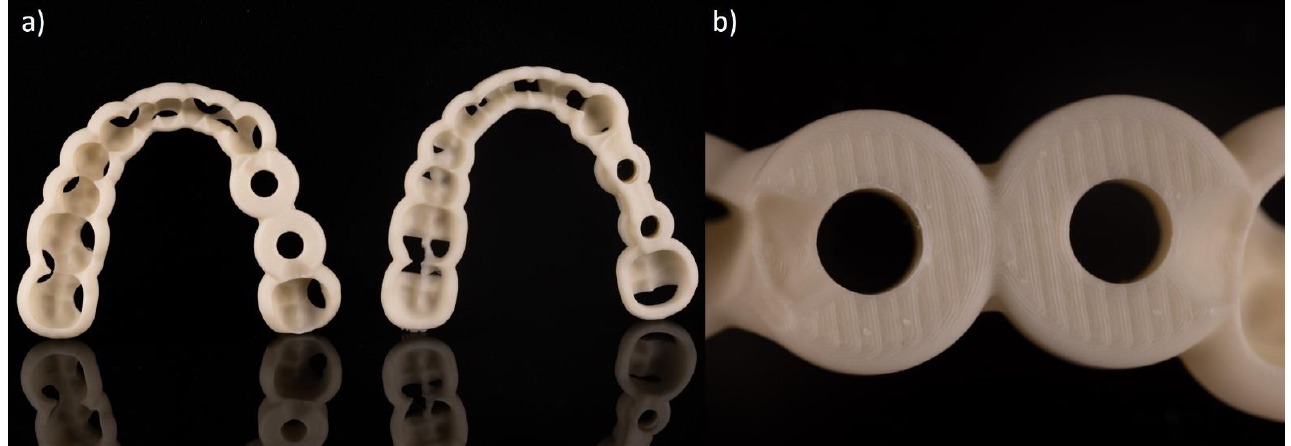
Figure 6. ( a ) Two FFF printed implant templates planed with coDiagnostix (l.) and ImplantStudio (r.). In both cases, the exported STL file was transferred to the slicer software and printed without further modification. ( b ) Close-up of the coDiagnostix surgical guide showing the guiding structure. The individual layers of the filament print become visible.